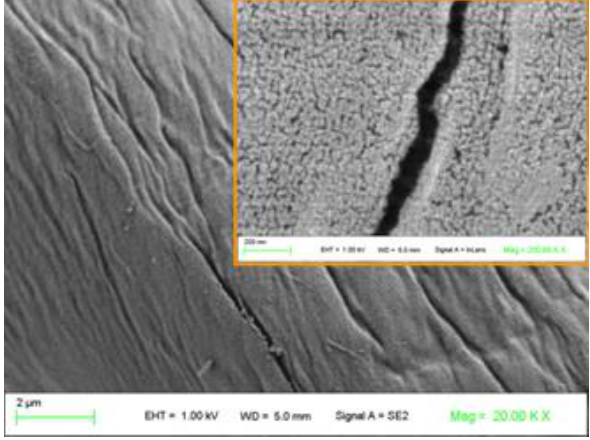
Figure 2: FE-SEM images of cotton fibres covered by a layer of TiO 2 NPs after a hydrothermal temperature of 130 ∘ C; in the inserted window, a more resolved image shows a thin layer of TiO covering the whole cotton surface [24]; reprinted (modified) with permission from Royal Society of Chemistry